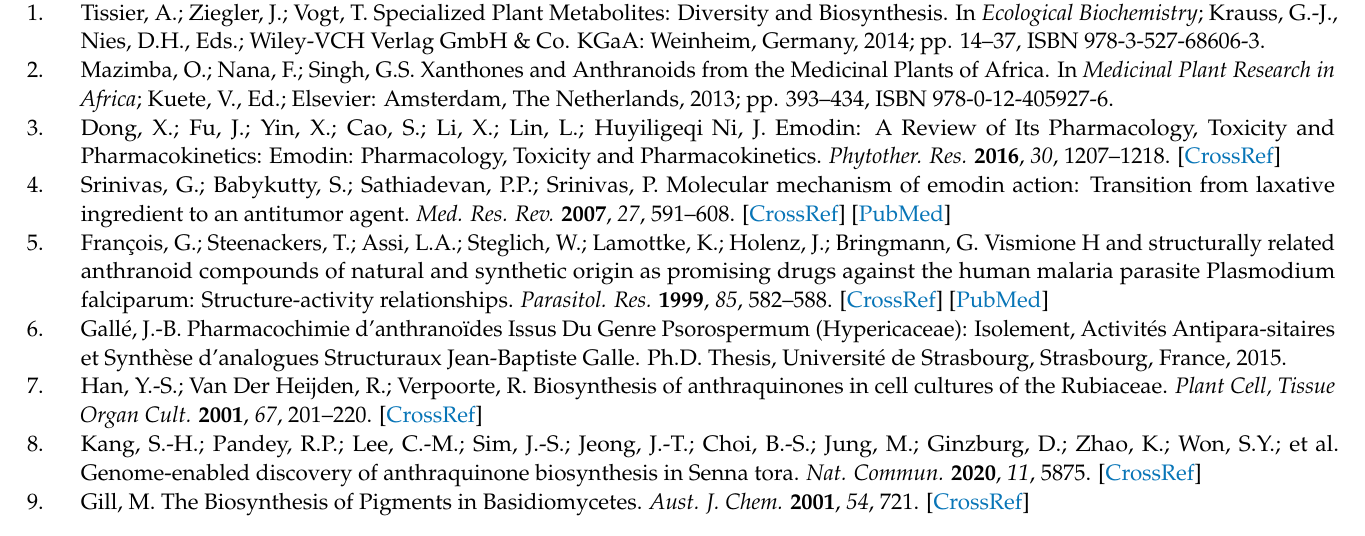
Table S2: Metabolites identified in non-targeted metabolomic analysis of MeOH extracts from BY-2 cells treated with 50 µ M Lap, Table S3: Metabolites identified in non-targeted metabolomic analysis of MeOH extracts from BY-2 cells treated with 50 µ M Fra, Table S4: Metabolites identified in non- targeted metabolomic analysis of MeOH extracts from BY-2 cells treated with 50 µ M Qui, Table S5: BY-2 cells treated with 50 µ M Emo, Mad and